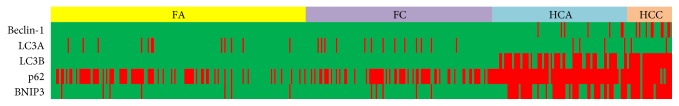
Heat map showing the expression of autophagy-related proteins in follicular neoplasms and Hürthle cell neoplasms. FA: follicular adenoma; FC: follicular carcinoma; HCA: Hürthle cell adenoma; HCC: Hürthle cell carcinoma; green: negative; red: positive.